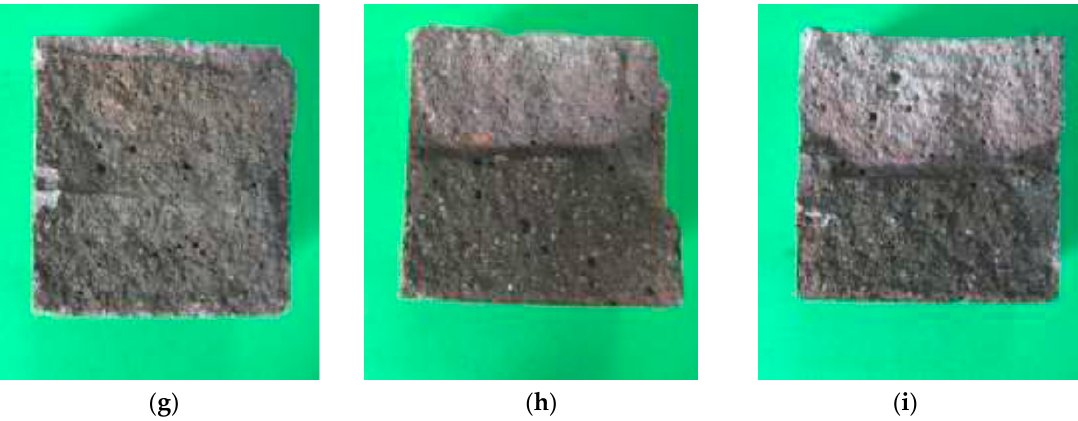
Figure 9. Sample of mortar extracted from the steel/specimen interface: ( a ) CEM I; ( b ) 25CV; ( c ) 35CV; ( d ) 10CVF; ( e ) 25CVF; ( f ) 35CVF; ( g ) 10CF; ( h ) 25CF and ( i ) 35CF.